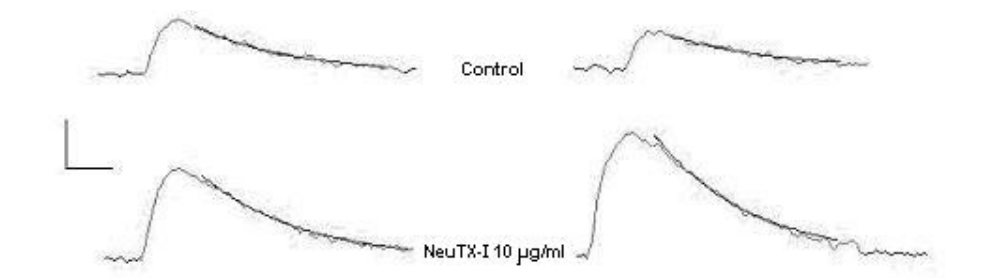
Figure 5. Spontaneous miniature end-plate currents recorded at mouse neuromuscular junction. The figure shows digitized raw data related to control and treatment with NeuTX-I concentration of